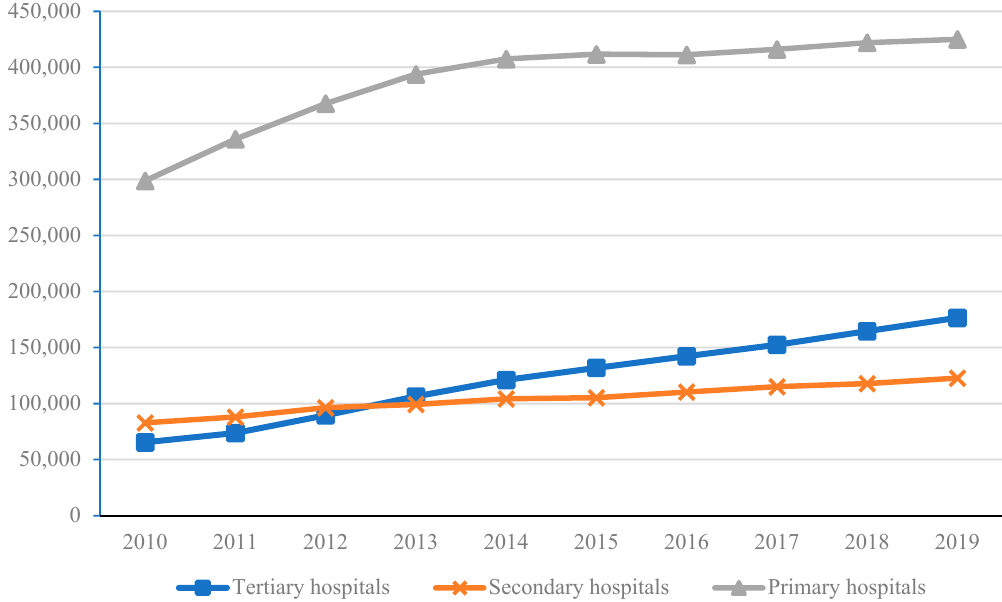
Figure 2. Annual cumulative total number of patients in medical institutions at all levels (10,000 people). Data: National Health Commission of the PRC.